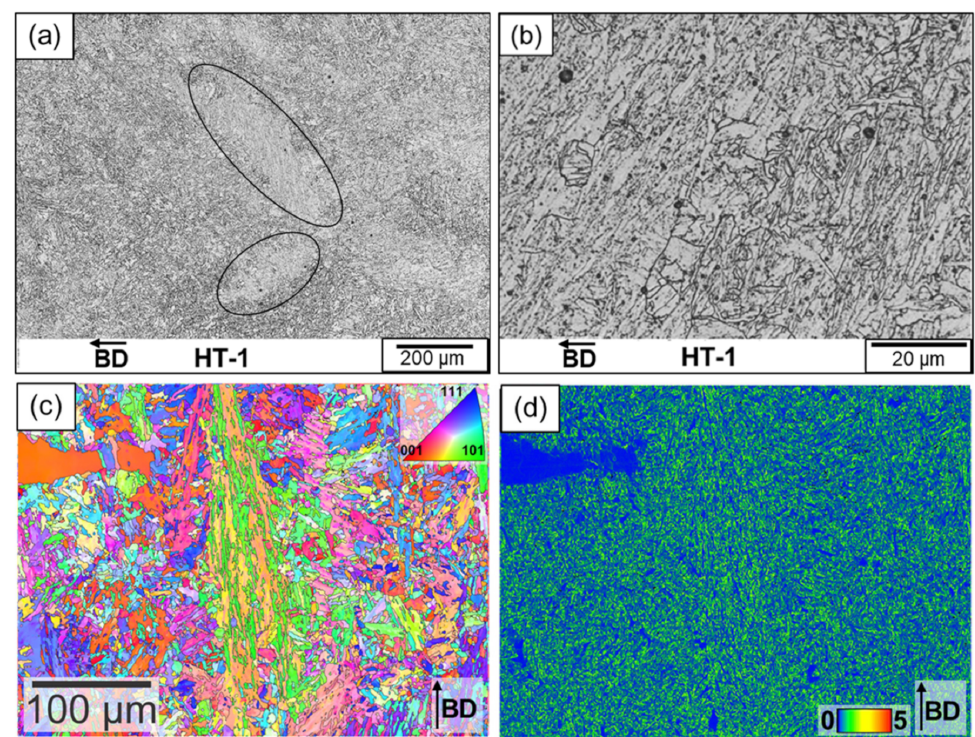
Figure 8. Characterization of the samples after PPHT (HT-1 treatment) ( a ). Optical micrographs showing a highly directional anisotropic tempered martensite structure (circles), ( b ) with sporadic delta ferrite stringers ( c ). Inverse pole figure ( d ). Kernel average misorientation maps clearly showing the presence of delta ferrite and abnormal growth in the top left corner of ( d